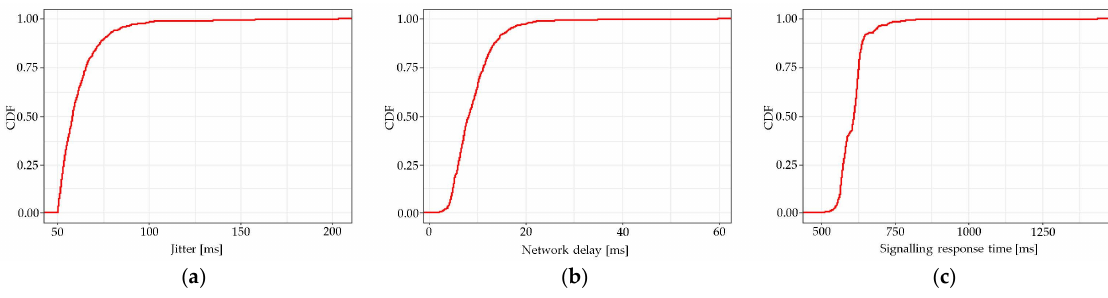
Figure 6. Cumulative density function of network